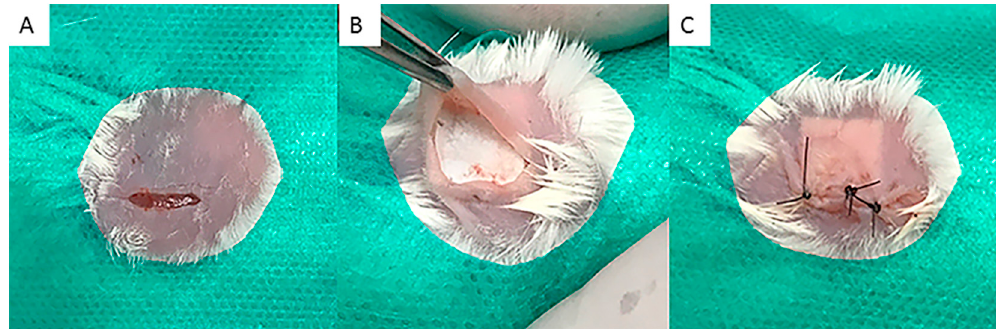
Figure 1. Sequence of surgical procedures performed. (A) Trichotomy, skin antisepsis of the back region of the animals and incision of approximately 1cm on the back region of the animals, according to ISO 10993-6/2016; (B) After divulsion of the cutaneous tissue, a 1-cm fragment of membrane was implanted and tested according to the experimental groups; (C) Replacement of cutaneous tissue over the implanted membrane and suture with 5-0 mononylon (Ethicon®, Johnson & Johnson, Brazil).